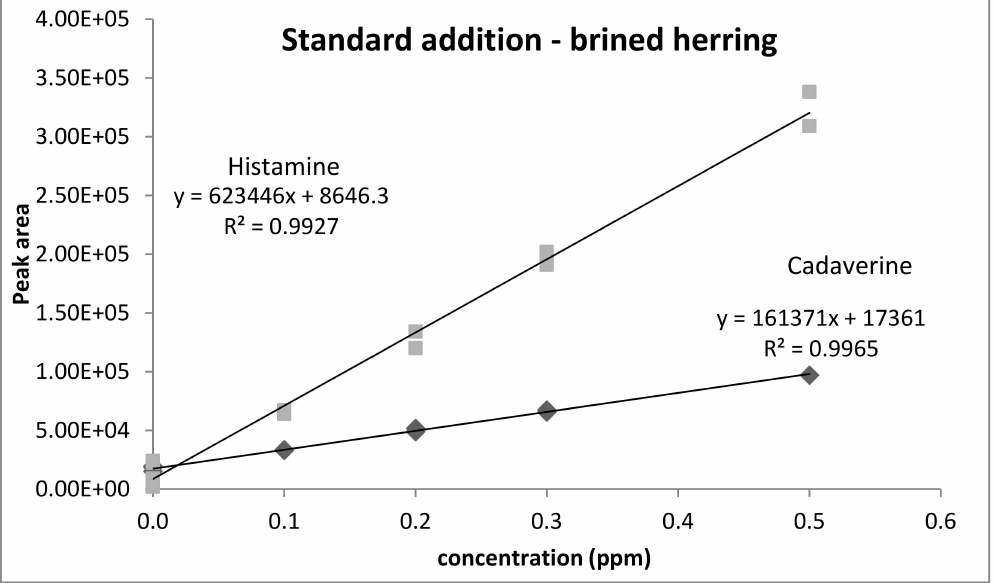
Figure 2. Determination of histamine and cadaverine by the standard addition